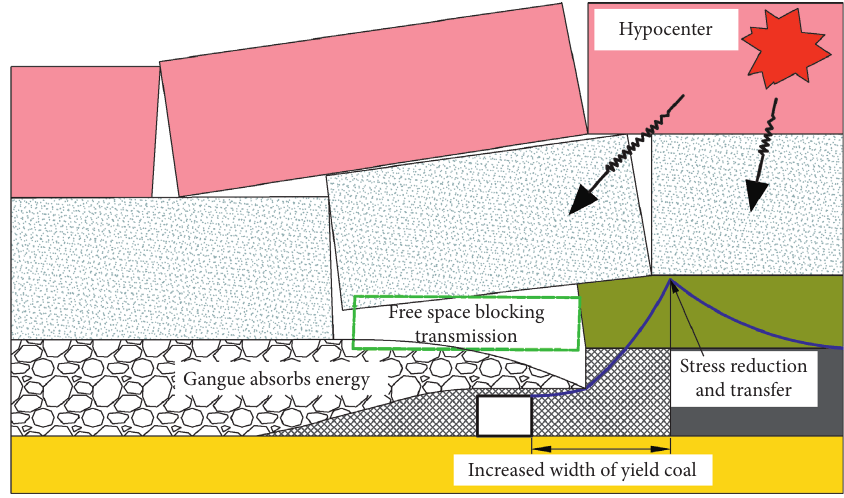
Figure 10: Principle of preventing